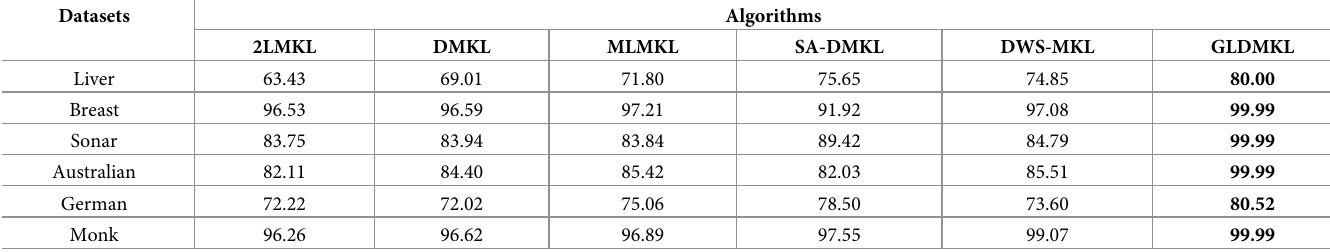
Table 4. Comparison of best classification